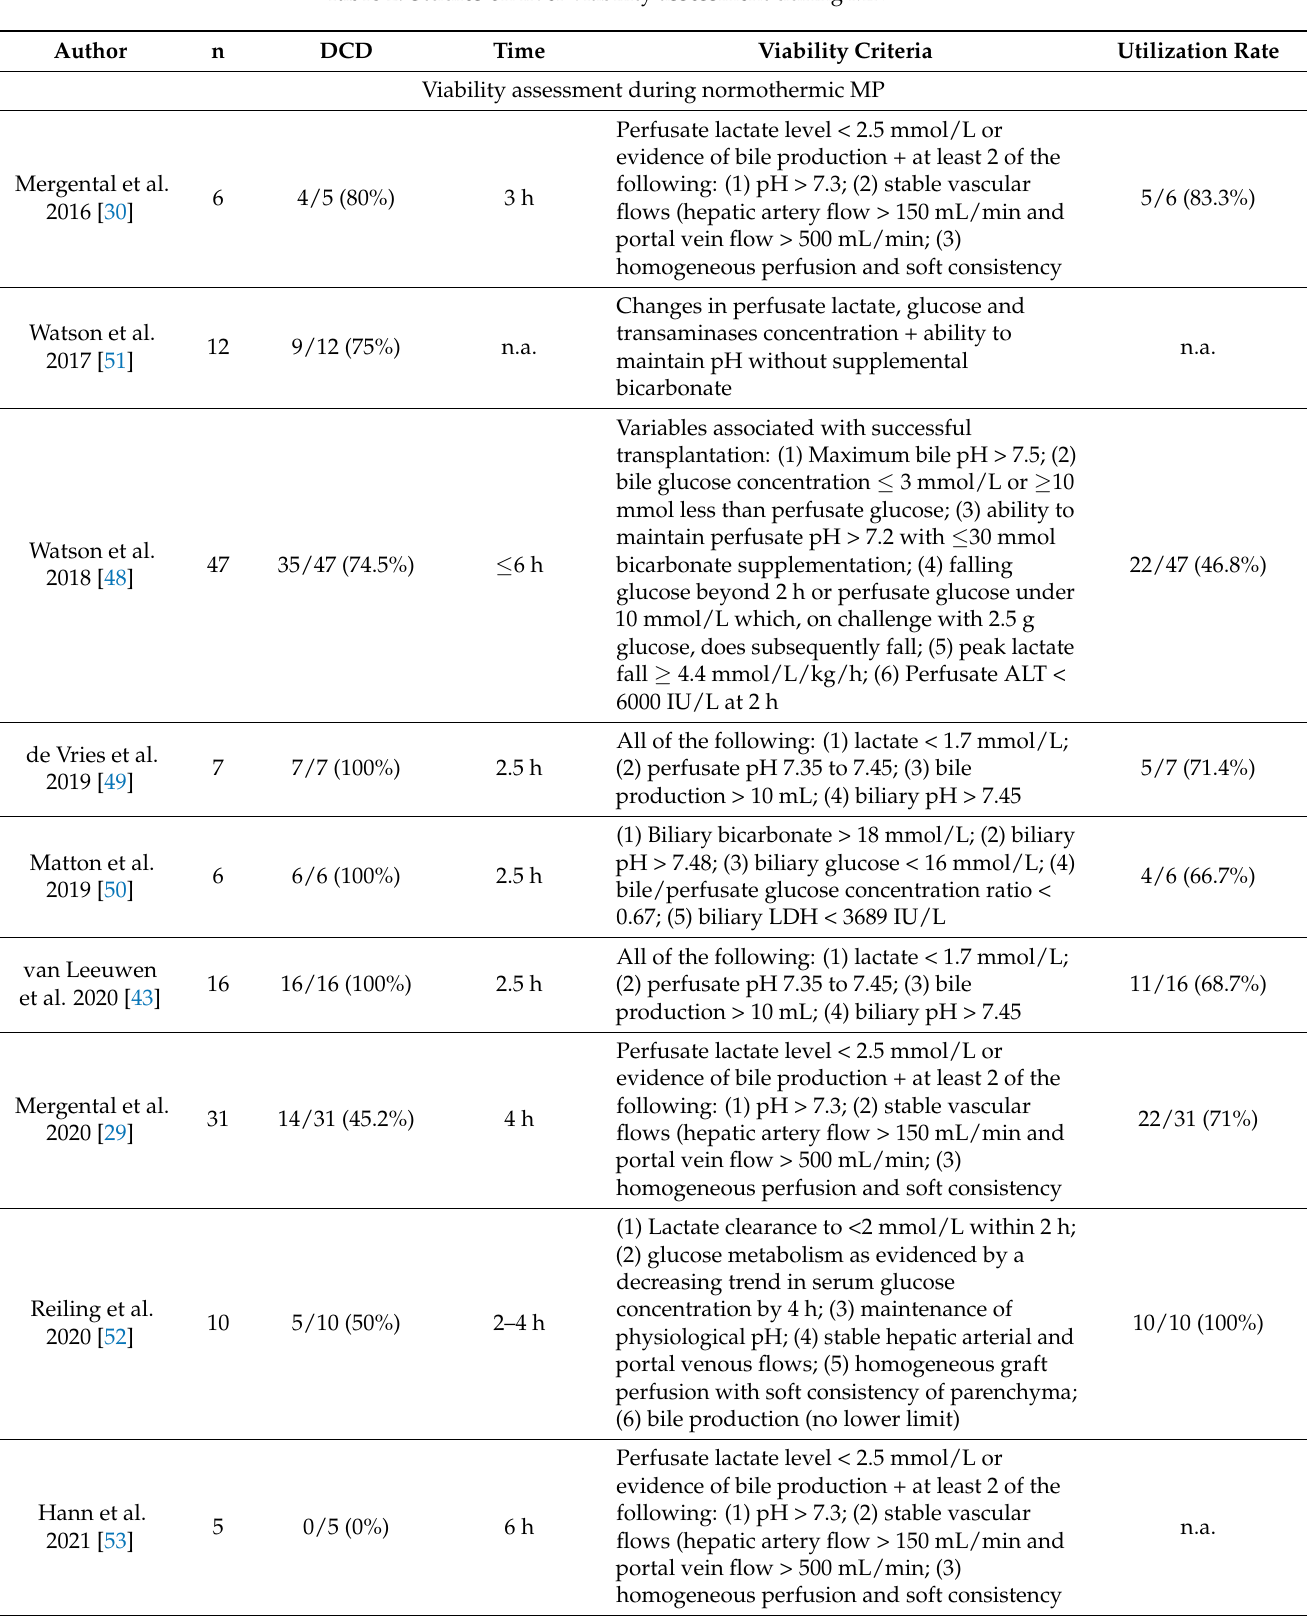
Table 2. Studies on liver viability assessment during